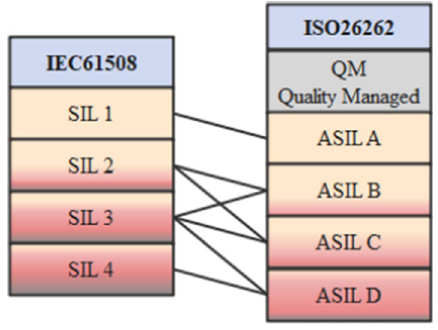
Fig. 3 Approximate cross-mapping of Safety Integrity